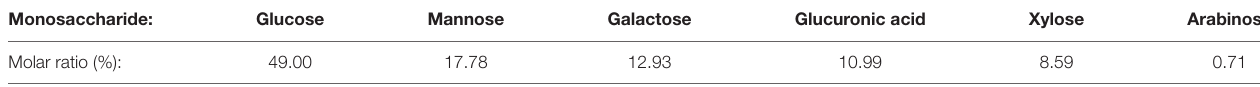
TABLE 1 | Monosaccharide composition of Heimioporus retisporus Polysaccharide (HRP). Monosaccharide: Glucose Mannose Galactose Glucuronic acid